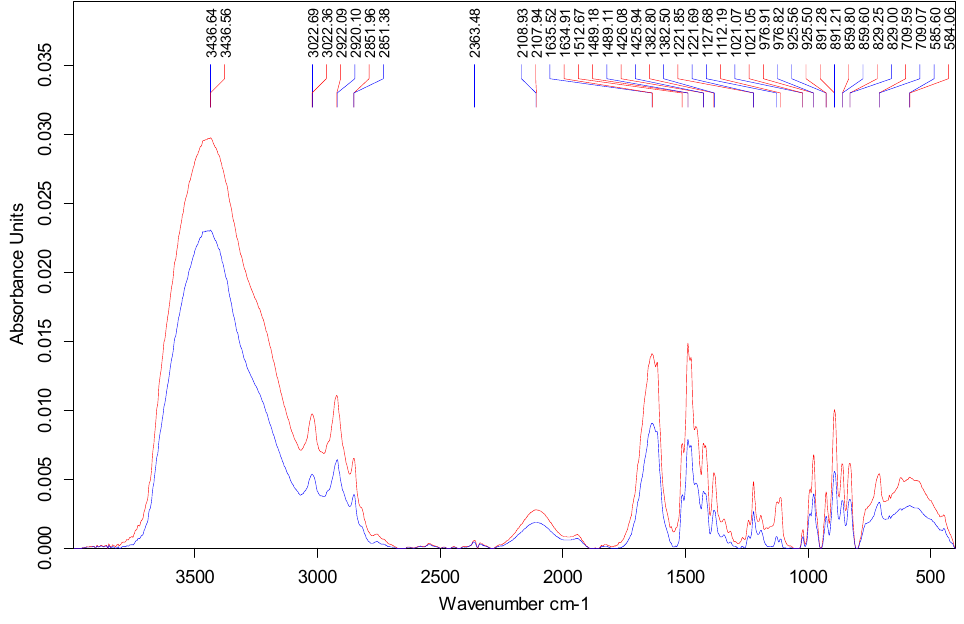
Figure 13. FTIR spectra of pure IRA 402(Cl − ) resin and of AB113 loaded resin.